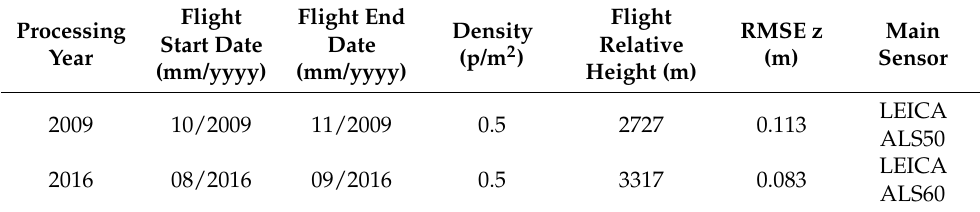
Table 1. Basic parameters of the LiDAR datasets from La Uni ó n used in this study [37,38].